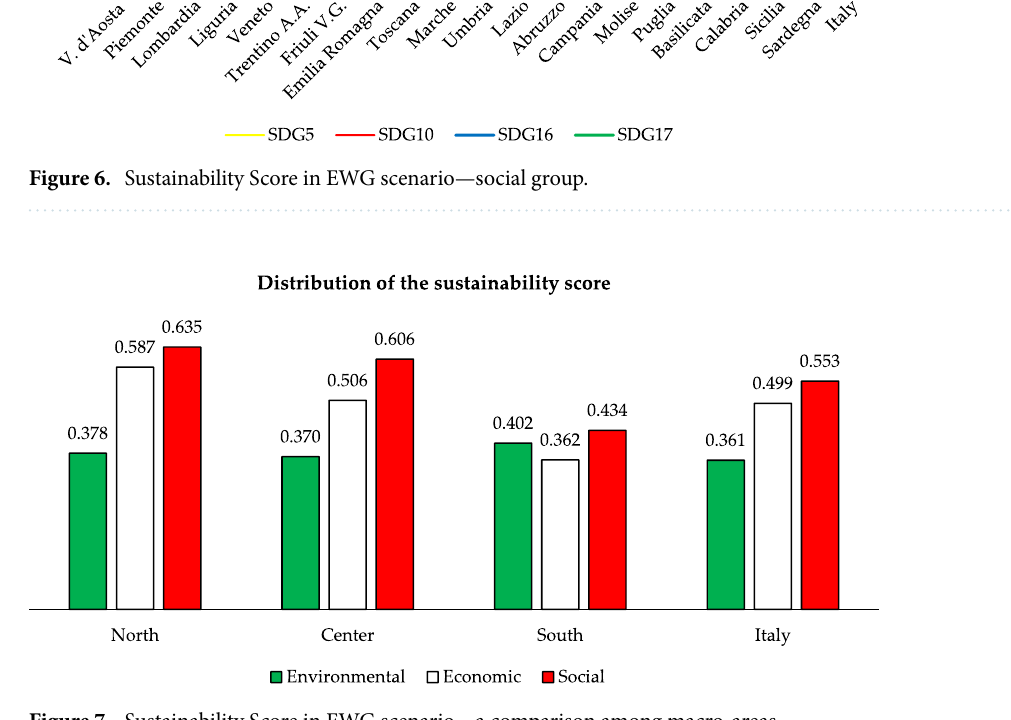
Figure 7. Sustainability Score in EWG scenario—a comparison among